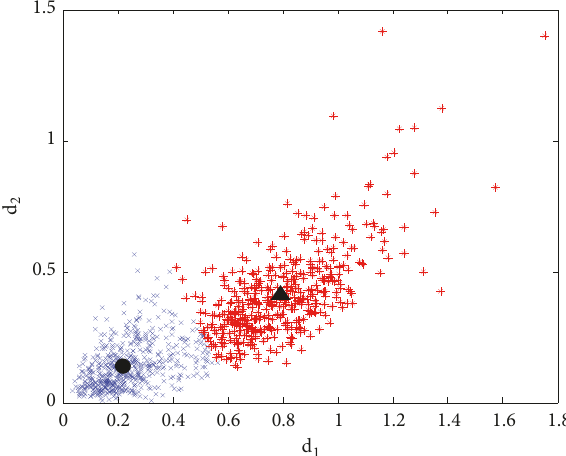
Figure 5: Classification of the K-medoids clustering algorithm with